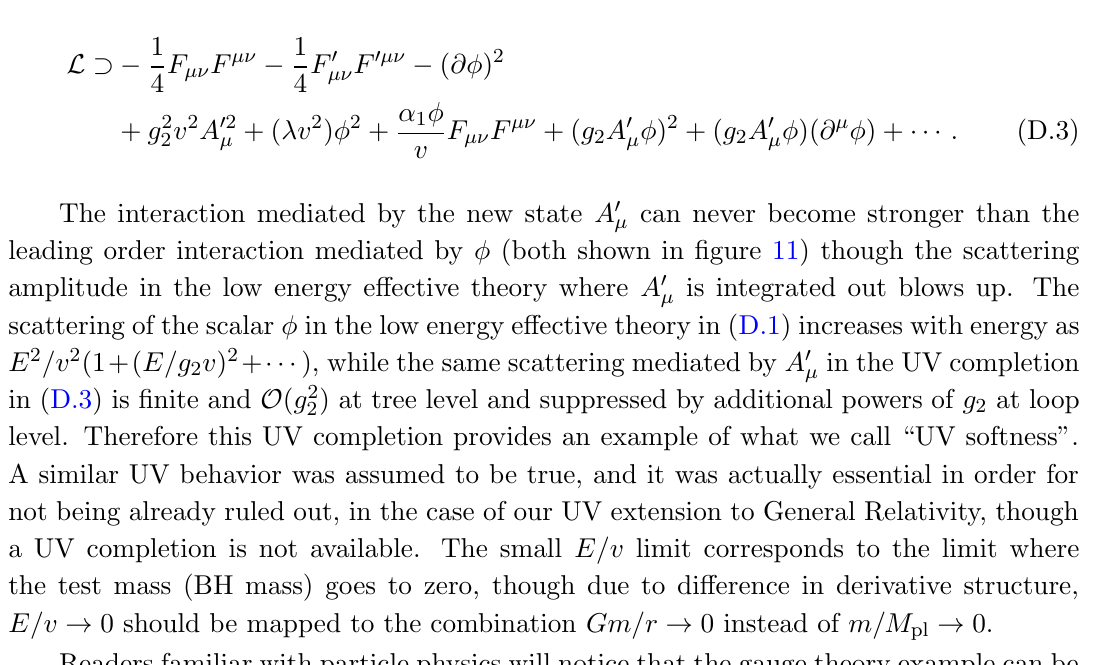
Figure 11 . (Left) The interaction between photons mediated by the scalar (cid:30) which is similar to the gravitational interaction between matter in General Relativity. (Middle) The interaction mediated ~ 2 , ~ 2 , by the scalar (cid:30) with the e(cid:11)ective operator similar to the interaction studied in this paper, C C C C which has a UV cuto(cid:11) at g 2 v . (Right) The interaction between photons mediated by the scalar (cid:30) and the gauge boson A 0 as a UV completion of the diagram in the middle. (cid:22) at energies larger than g 2 v